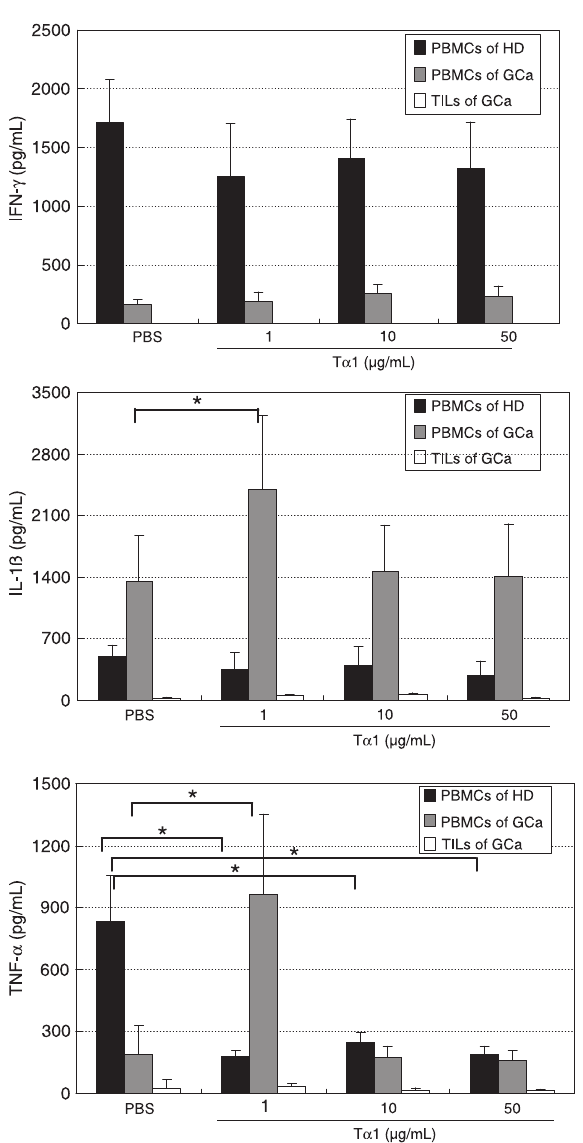
Figure 2. Effect of Tα1 on Th1 cytokine secretion in PBMCs from healthy donors (HD) and gastric cancer patients (GCa) and in TILs from gastric cancer patients. PBMCs and TILs were cultured with PBS or 1, 10, or 50 µg/mL Tα1 for 72 h. The levels of Th1 cytokines were determined using the Bio-Plex cytokine assay. PBMCs = peripheral blood mononuclear cells; TILs = tumor- infiltrating lymphocytes. Data are reported as means ± SD for 3 separate experiments (P < 0.05, t -test).